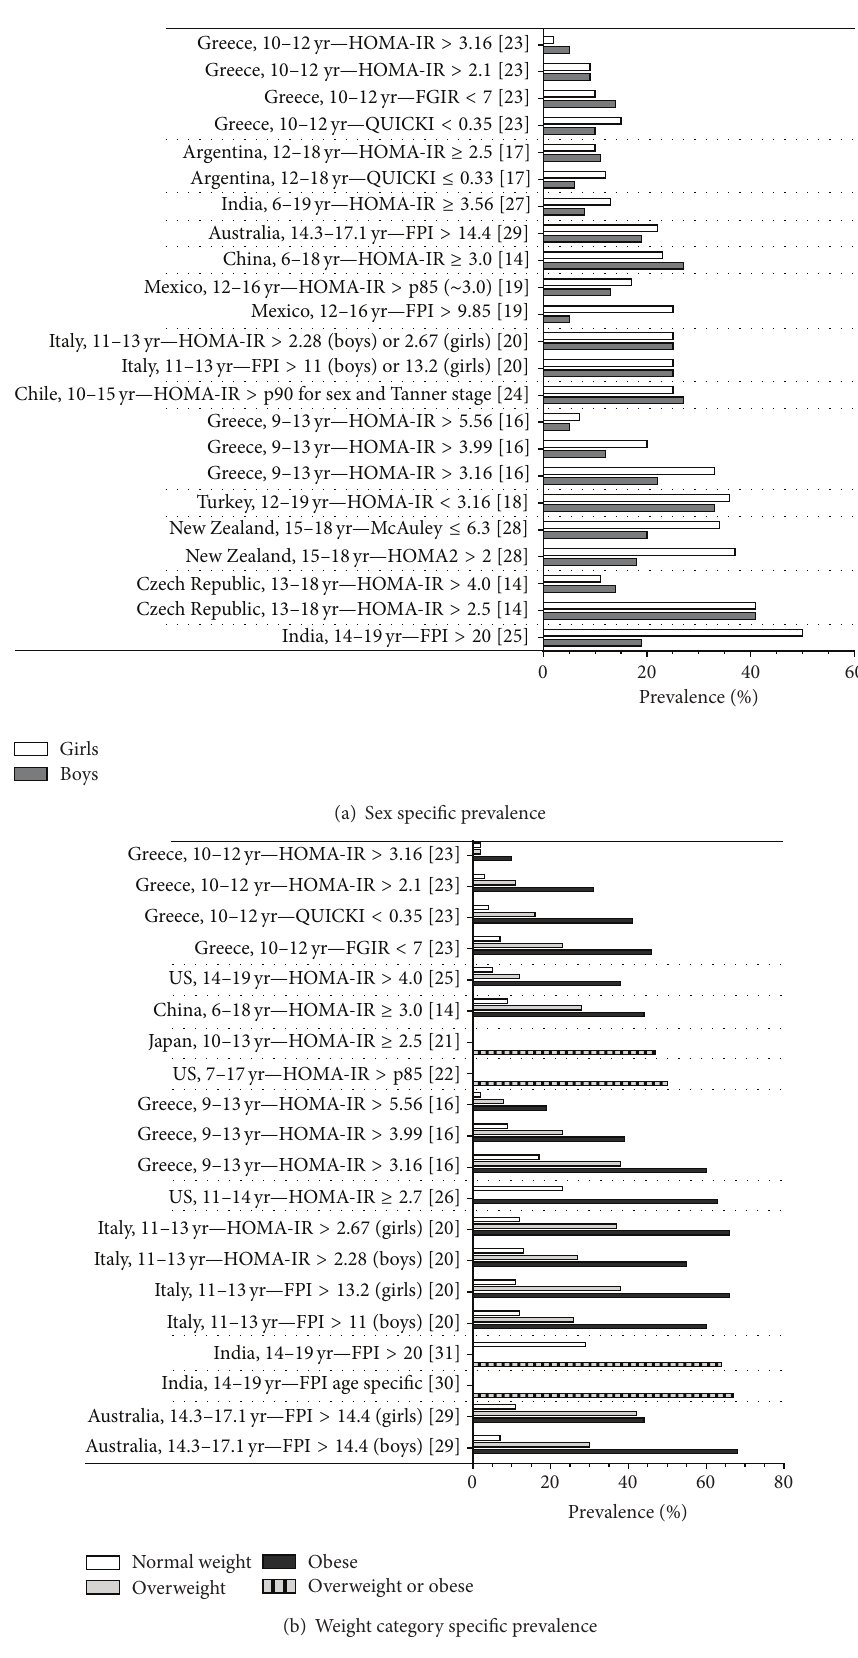
Figure 3: Prevalence of IR by sex (a) and weight category